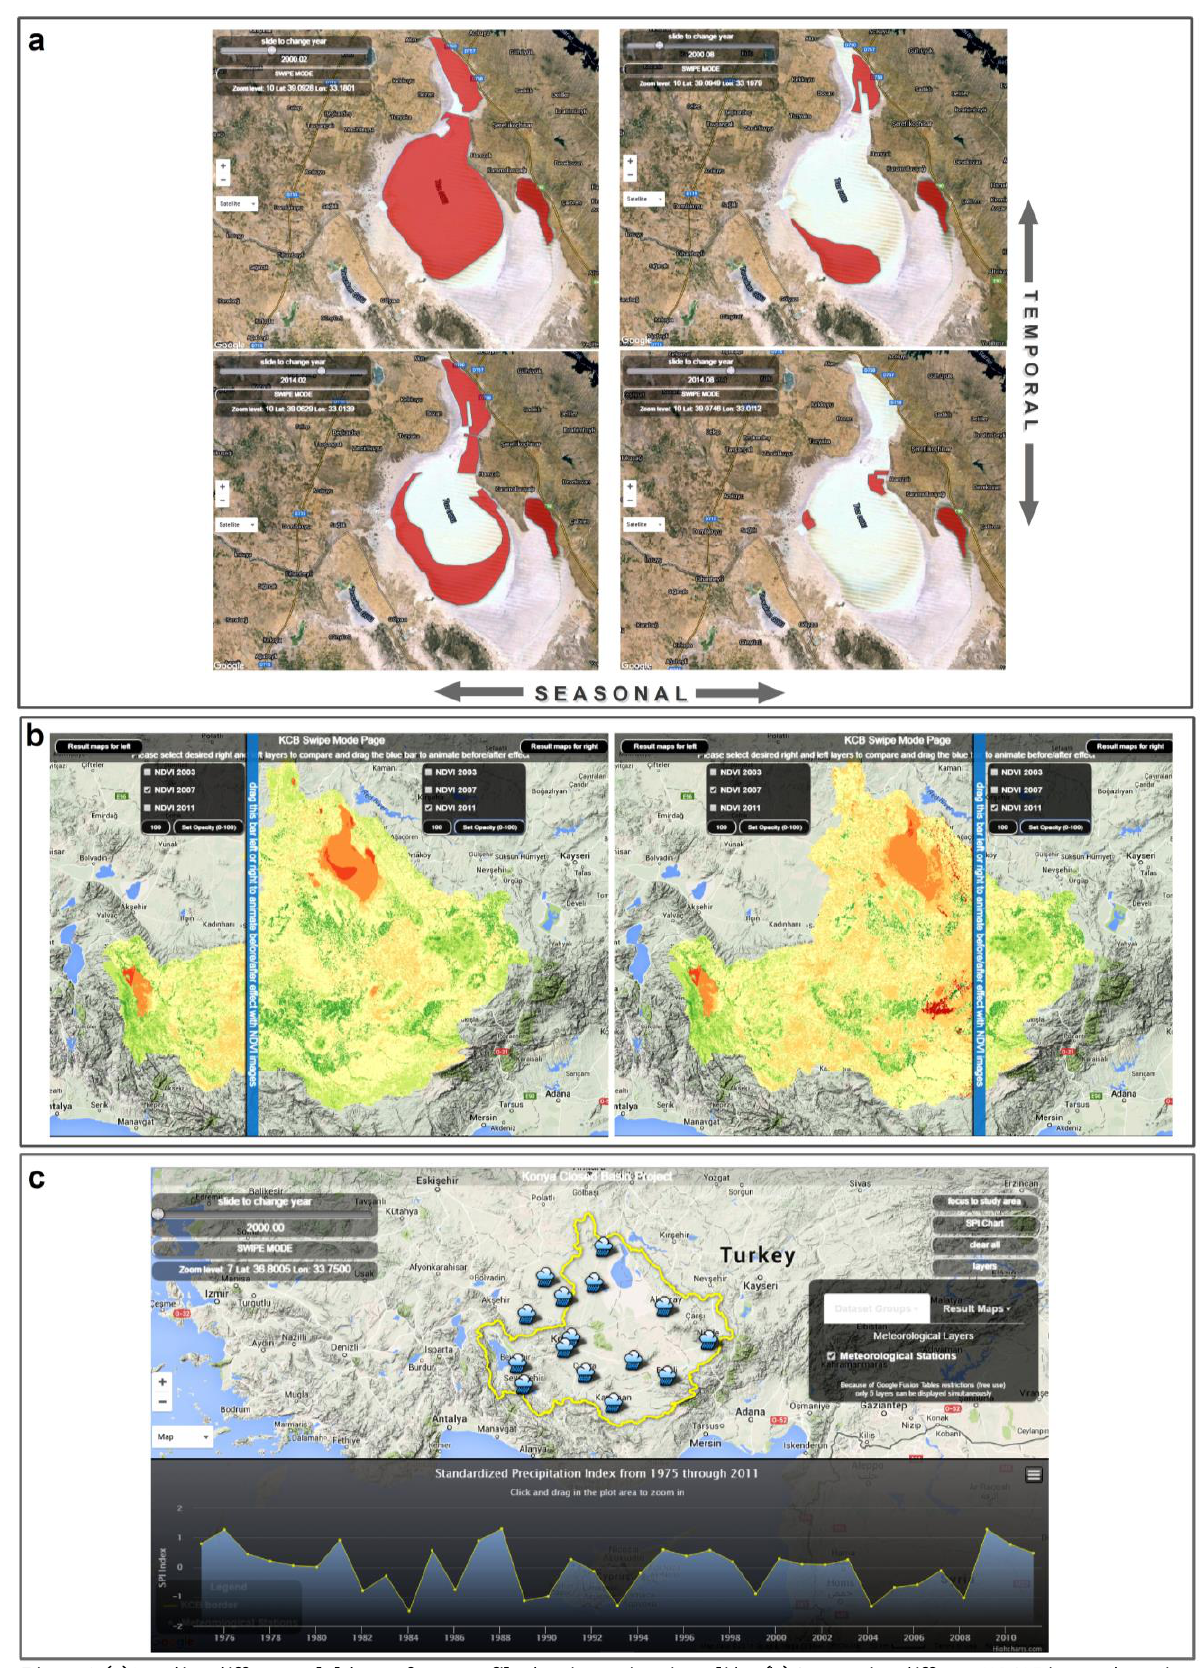
Figure 1 (a) Loading different salt lake surface area files by time using time slider (b) Comparing different NDVI images by using swipe mode tool (c) Interactive SPI chart produced by High Charts